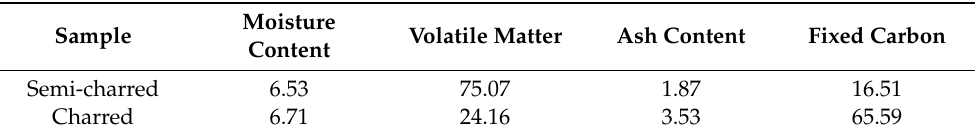
Table 2. Proximate analysis results for charred and semi-charred samples. Percentages values of moisture content, volatile matter, ash content and fixed carbon are the average of 2 replicates. Fixed carbon was calculated on dry